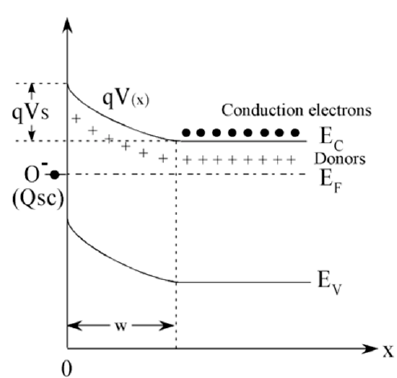
Figure 1. Schematic representation of the energy band diagram of an n-type semiconductor, such as SnO2, upon chemisorption. E f , E c , E v represent the Fermi energy, the edge of the valence band of the semiconductor and of the edge of its conduction band, respectively. qV S is the Schottky barrier developed at the surface and Qsc the charge trapped at the acceptor surface states created by oxygen chemisorption. W is the depletion layer. Reprinted from [38], Copyright (2008), with permission from Elsevier.